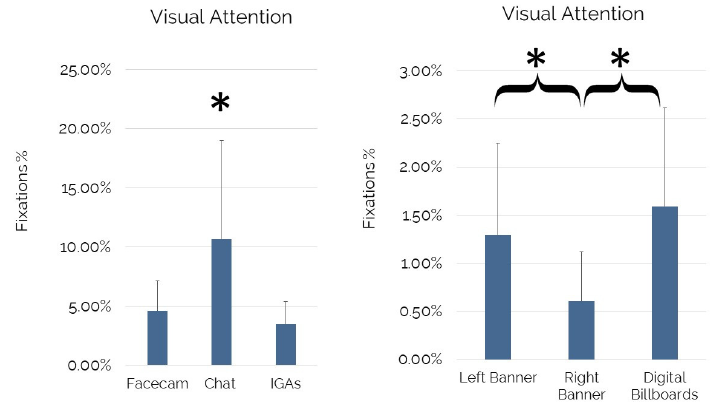
Figure 1. Visual attention for IGAs, Facecam, and Chat. Error bars represent standard deviation. Asterisks indicate statistically significant differences.